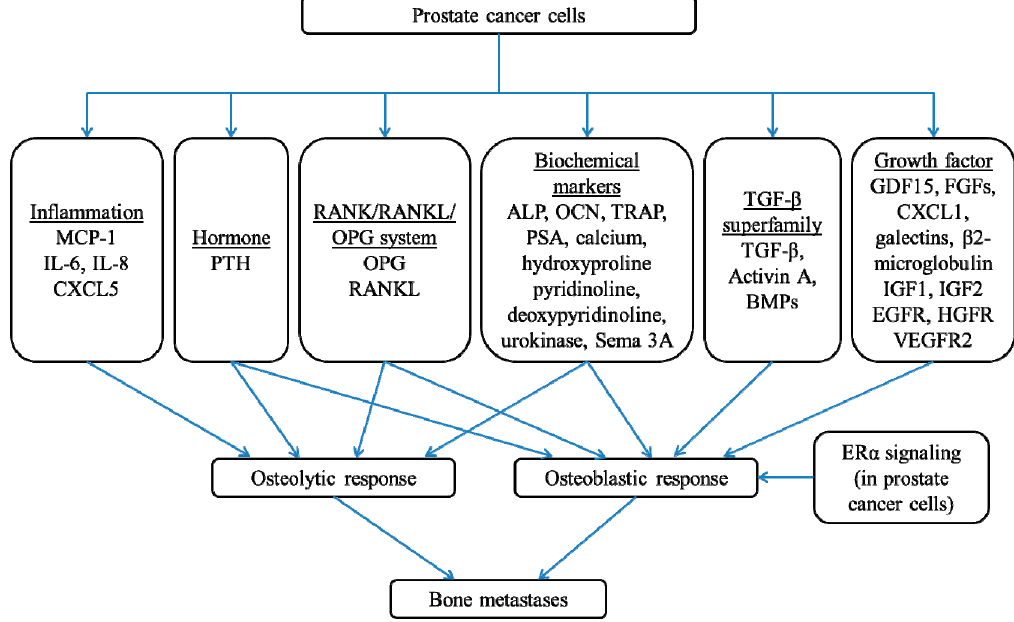
Figure 1. The signaling molecules involved in governing bone metastases driven by prostate cancer.